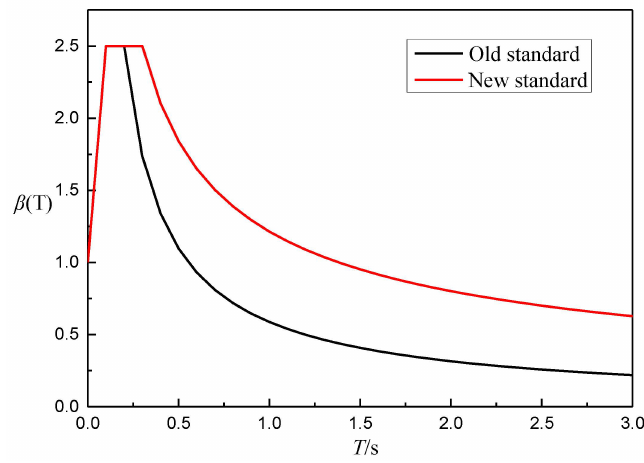
Figure 1. Comparison of the design response spectrum in the new and old standards (Class I